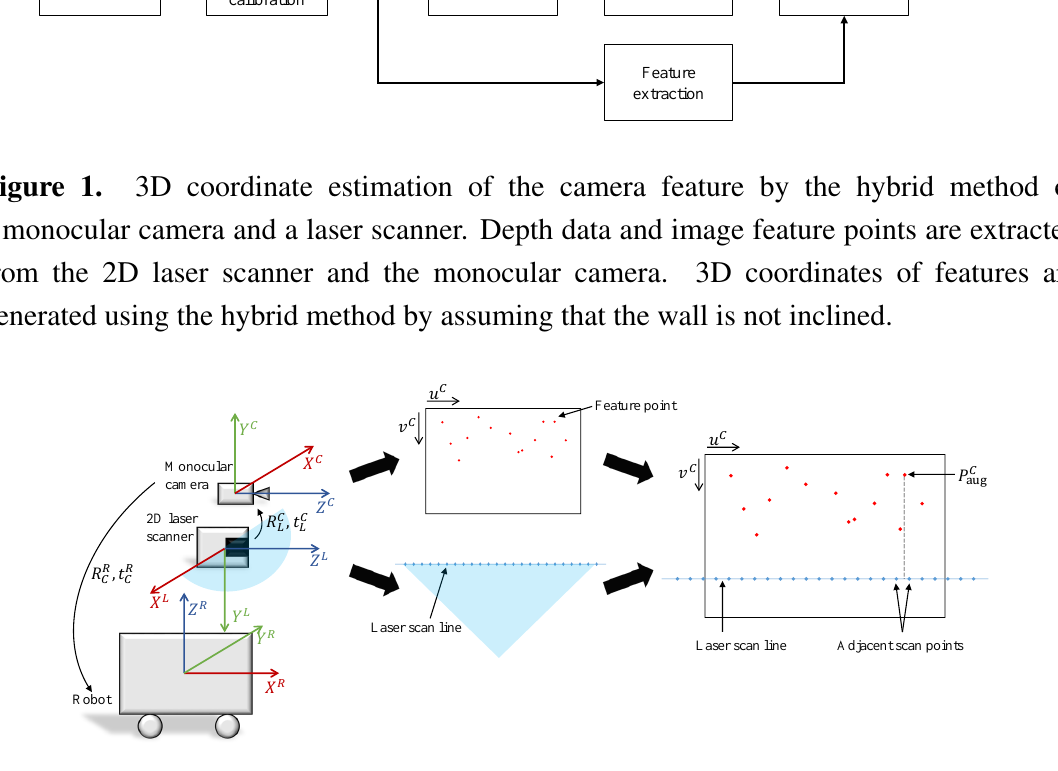
Figure 2. The concept of the hybrid method. Coordinate systems of the monocular camera, the 2D laser scanner and the robot are shown. The depth value of the feature point can be acquired from the depth value of the laser scan point on the same u C